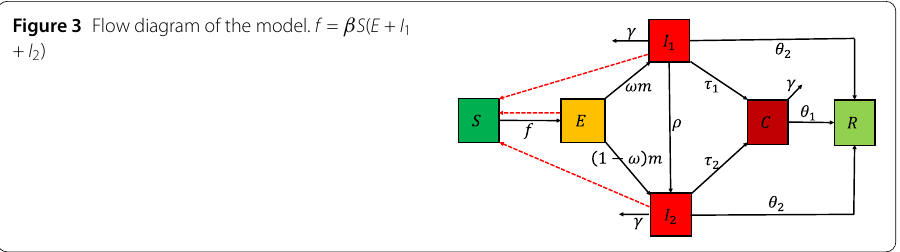
Figure 3 Flow diagram of the model. f = β S ( E + I 1 +